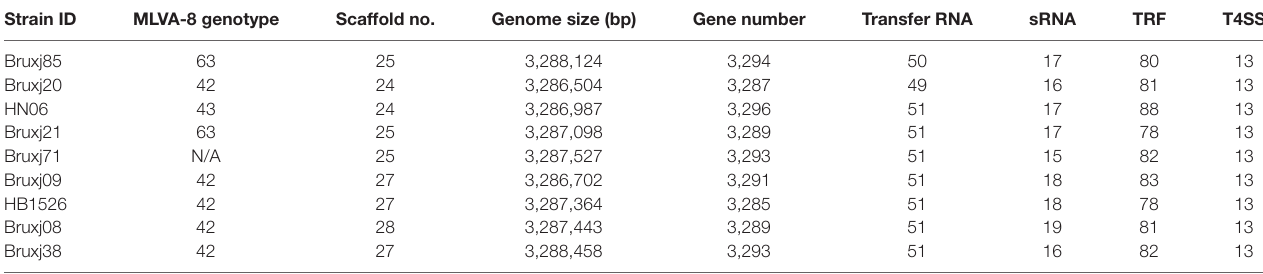
TaBle 3 | Genomic features of nine Brucella melitensis strains isolated from China. strain iD MlVa-8 genotype scaffold no. genome size (bp) gene number